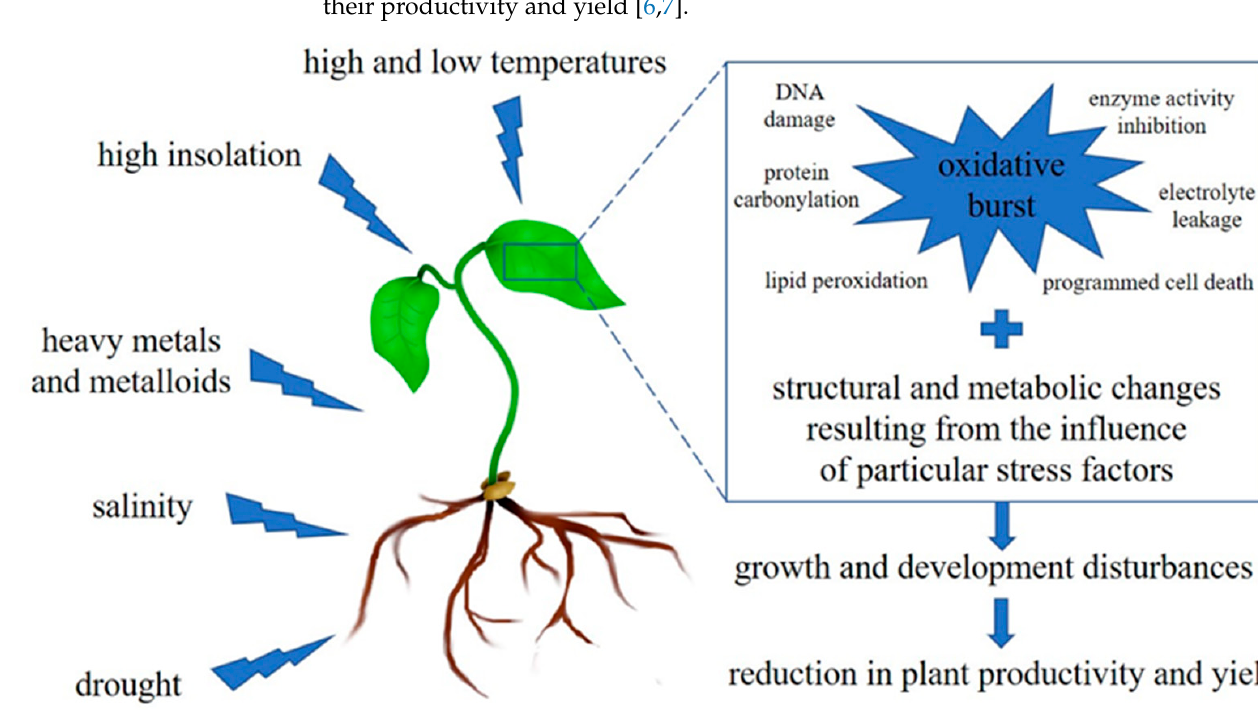
Figure 1. A simplified diagram of complex plant responses to stressful environmental stimuli: oxi- dative burst and its consequences as a universal reaction to different stressors are shown, as well as stressor-dependent reactions leading to plant growth retardation and a decline in productivity.